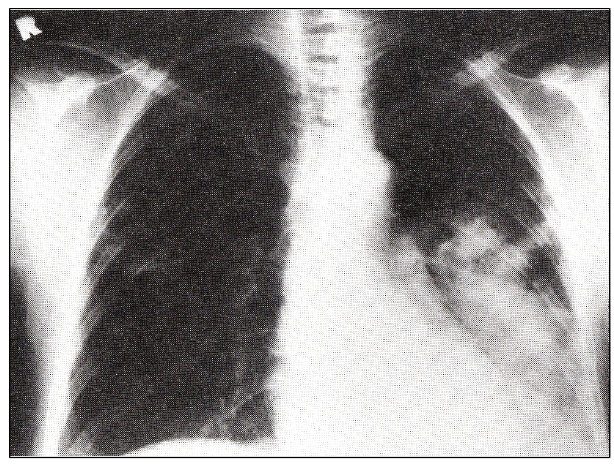
Fig ure 1) Chest ra dio graph of case 1 at ad mis sion. Note the ex ten sive left lower lobe opac ity. There is a barely visi ble opac ity on the right